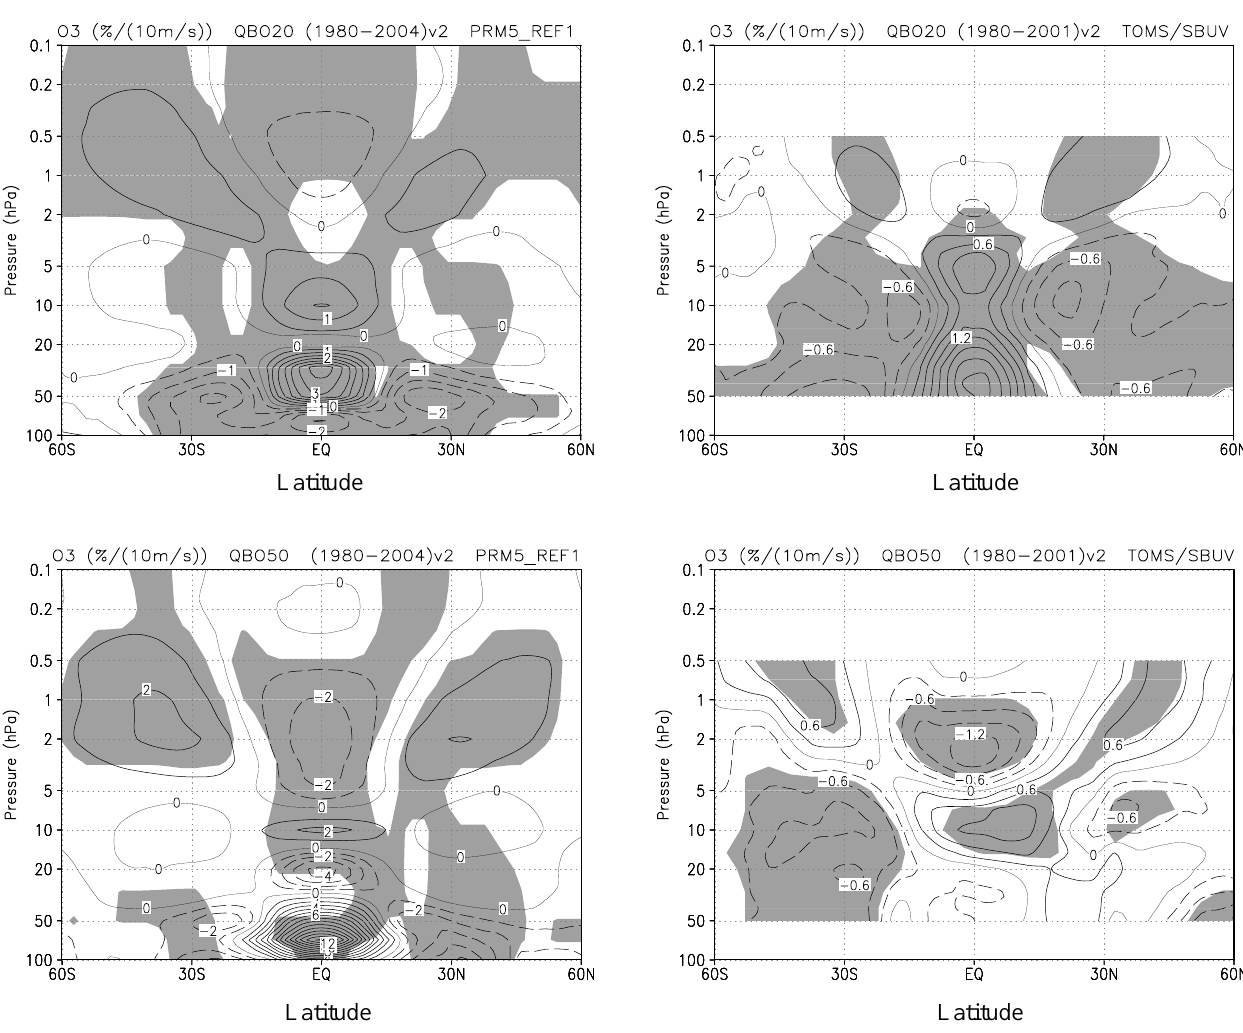
Fig. 14. Same as in Fig. 11 except for ozone in %/(10m/s). Contour interval is 1%/(10m/s) for the model and 0.3%/(10m/s) for Fig.14 Same as in Fig.11 except for ozone in %/(10m/s). Contour interval is 1 %/(10m/s) for the model, and 0.3 %/(10m/s) for ERA-40.